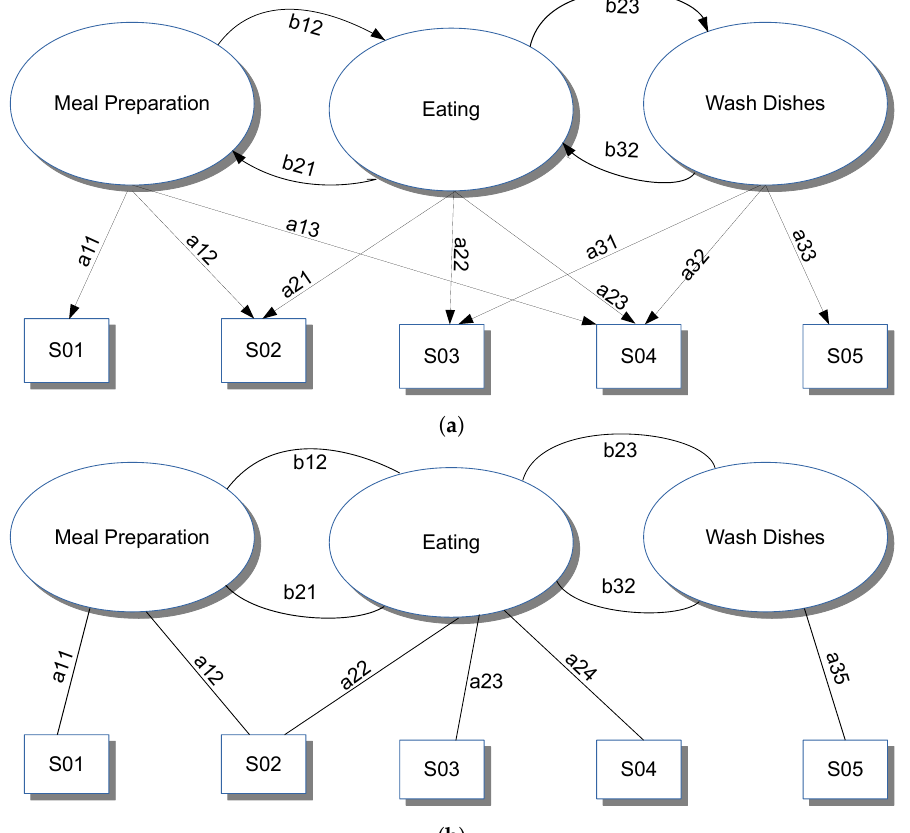
Figure 2. Examples of HMM and CRF models. Ellipses represent states (i.e., activities). Rectangles represent sensors. Arrows between states are state transition probabilities (i.e., the probability of moving from a state to another), whereas those from states to sensors are emission probabilities (i.e., the probability that in a specific state a sensor has a specific value). ( a ) HMM model example. Picture inspired by CASAS - HMM [14] and CASAS - HAM [15]. ( b ) CRF model example. Picture inspired by KROS - CRF